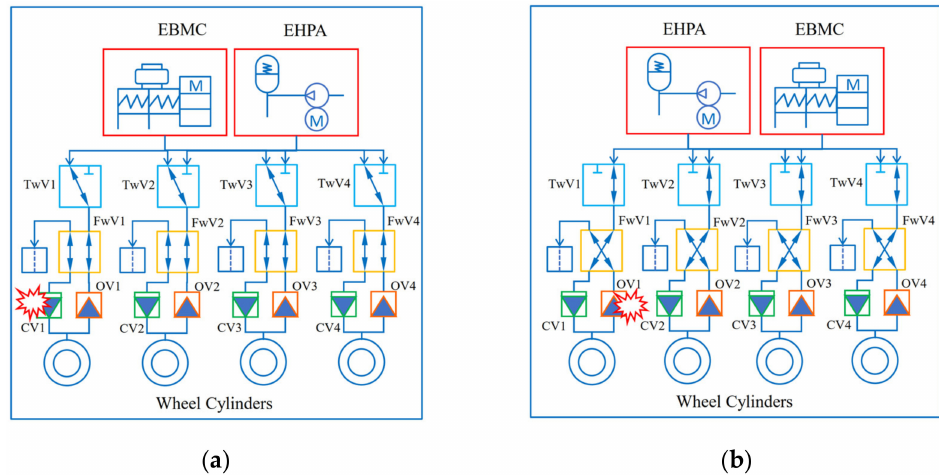
Figure 5. Degraded initiative braking F3 modes. F3 represents for the braking failure type 3 in hydraulic pressure modulator layer. ( a ) Braking with CV failure; ( b ) Braking with OV